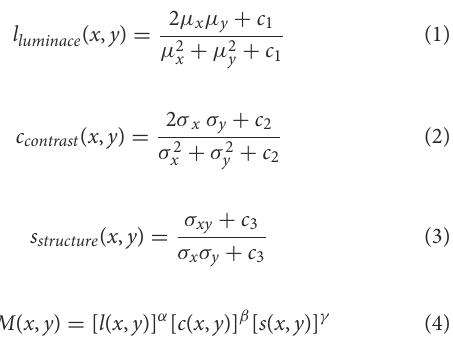
comparison measurements are luminance, contrast, and